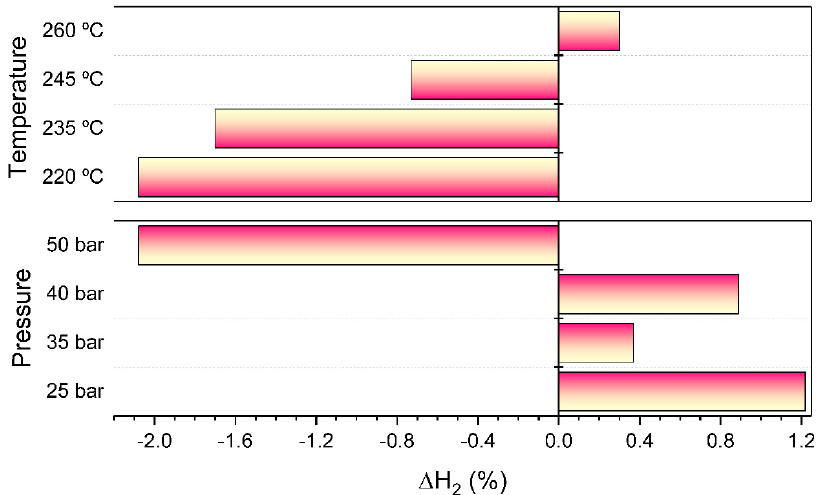
Figure 11. Evolution of product yields as a function of ( A ) temperature at P = 50 bar and ( B ) pressure at T = 220 °C over 0.3Pt/CoAl. Reaction conditions: W cat = 0.2 g, F H2O = 0.04 mL/min, F CO = 3.5 mL/min, F H2 = 14 mL/min.